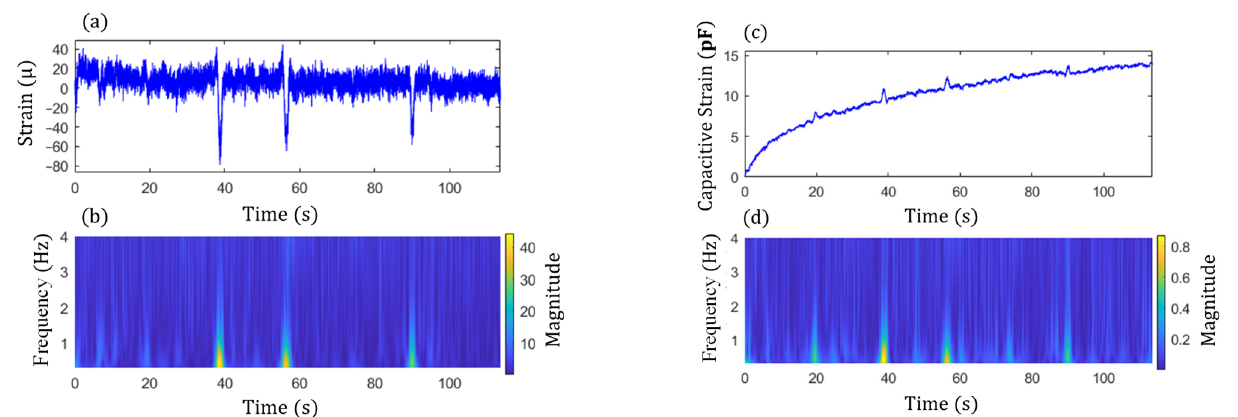
Figure 17. Multiple impulse traffic events: ( a ) raw data and ( b ) magnitude, |𝑊(𝑡, 𝑠)| (cid:3007) , of cross-frame strain, 𝐹(𝑡) , and ( c ) raw data and ( d ) magnitude, |𝑊(𝑡, 𝑠)| (cid:3004) , of large-area strain, ∆𝐶(𝑡) .